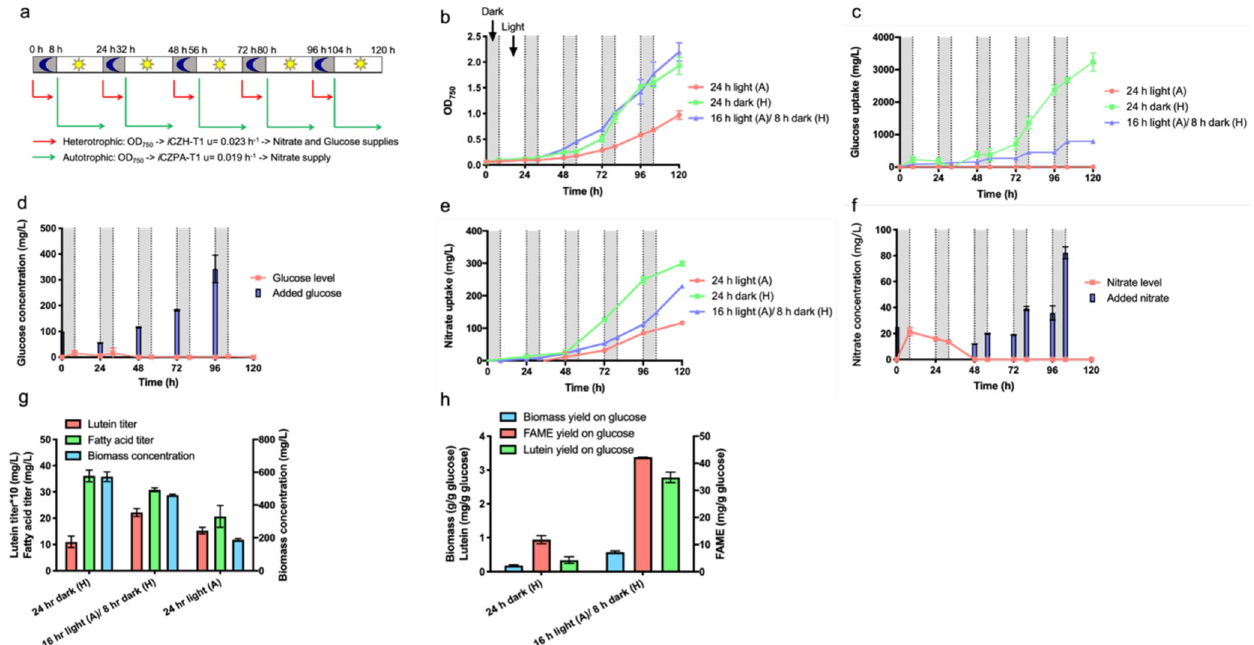
Fig. 1 C. vulgaris cultures under 24 h light autotrophic conditions (24 h light (A)), 24 h dark heterotrophic conditions (24 h dark (H)) and 16 h light autotrophic/8 h dark heterotrophic cycles (16 h light (A)/8 h dark (H)) with nutrient supplies predicted by genome-scale models. a Flowchart of model predictions over light/dark cycles. b Cell growth. c Glucose uptake in all three conditions. d Glucose feed and glucose concentration in the media under 16 h light (A)/ 8 h dark (H) cycles. e Nitrate uptake in all three conditions. f Nitrate feed and nitrate concentration in the media under 16 h light (A)/8 h dark (H) cycles. g Biomass concentration, fatty acid titer and lutein titer. h Biomass yield, Fatty acid yield and lutein yield on glucose. The data represents the mean ± SD for n = 3 (biological